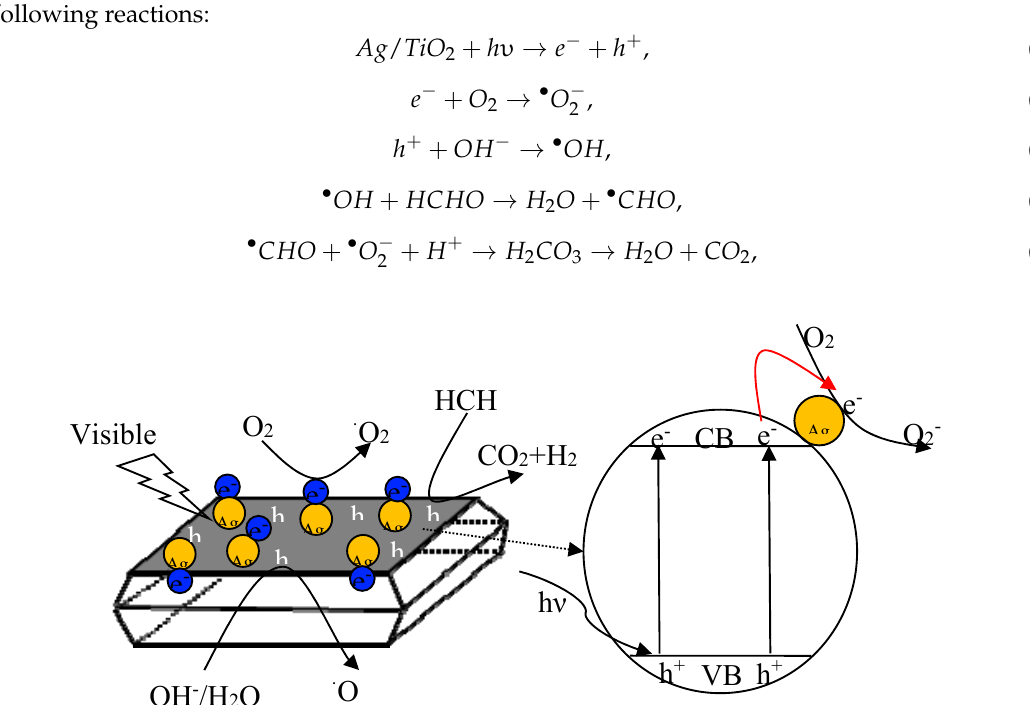
Figure 14. Schematic diagram illustrating the photocatalytic oxidation process of HCHO over Ag/TiO 2 NSs under visible light irradiation.